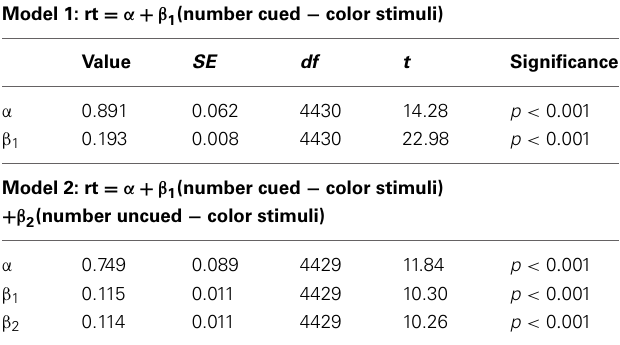
Table 3 | Intercepts and coefficients for the models generated by simple linear regression on the data from the full information, 0.9 conditional probability condition in Experiment